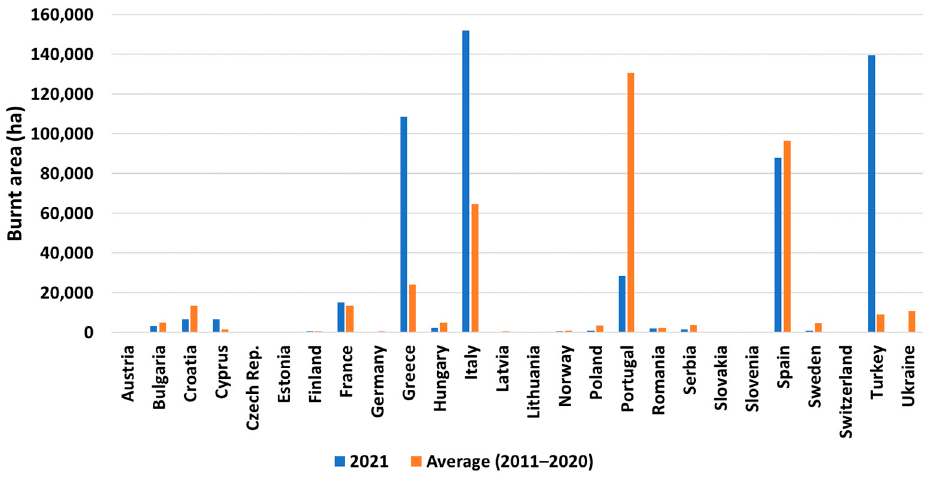
Figure 2. Land burned (ha) by wildfires in EU for 2021 and the average land burned (ha) by wildfires during the years 2011–2020.